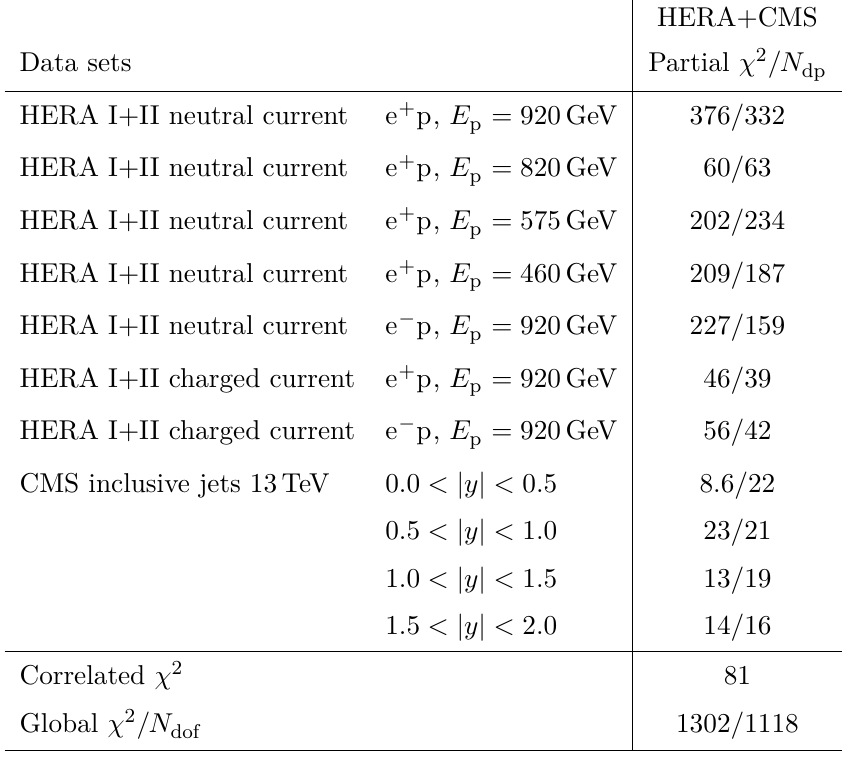
, and the global χ 2 per degree of freedom, N dp